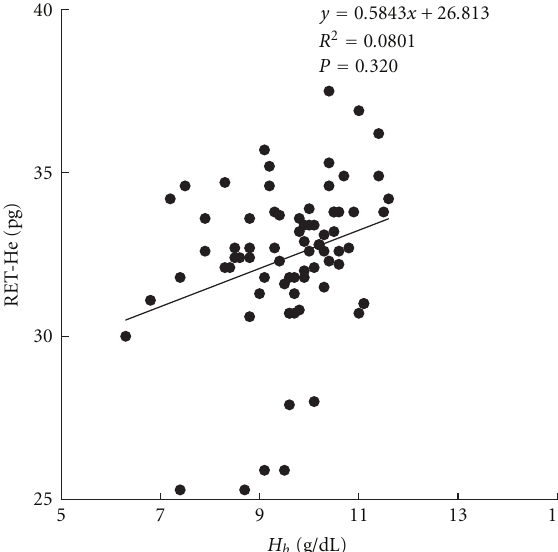
Figure 1: Correlation between serum hepcidin-25 levels and hemoglobin (Hb) concentrations.